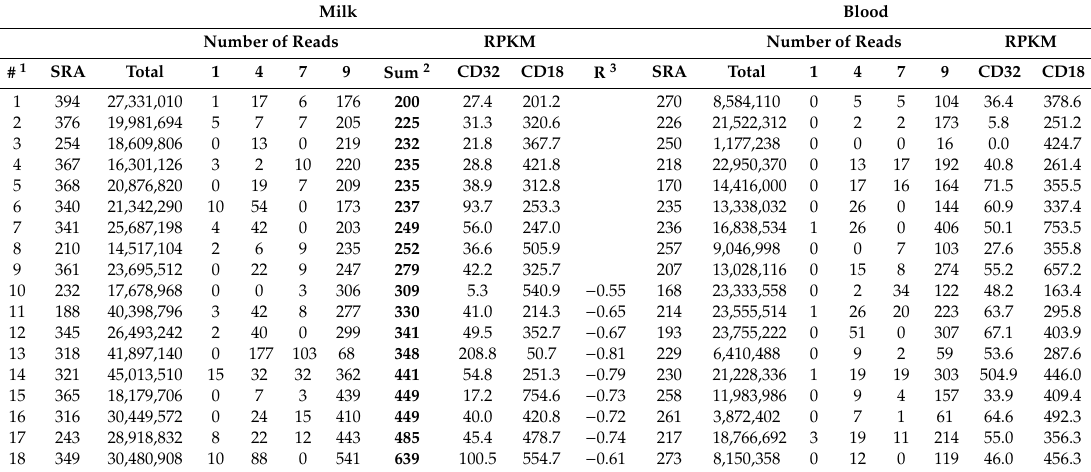
Table 2. Comparison of CD32 and CD18 read counts in milk and blood derived from RNA-Seq experiments in